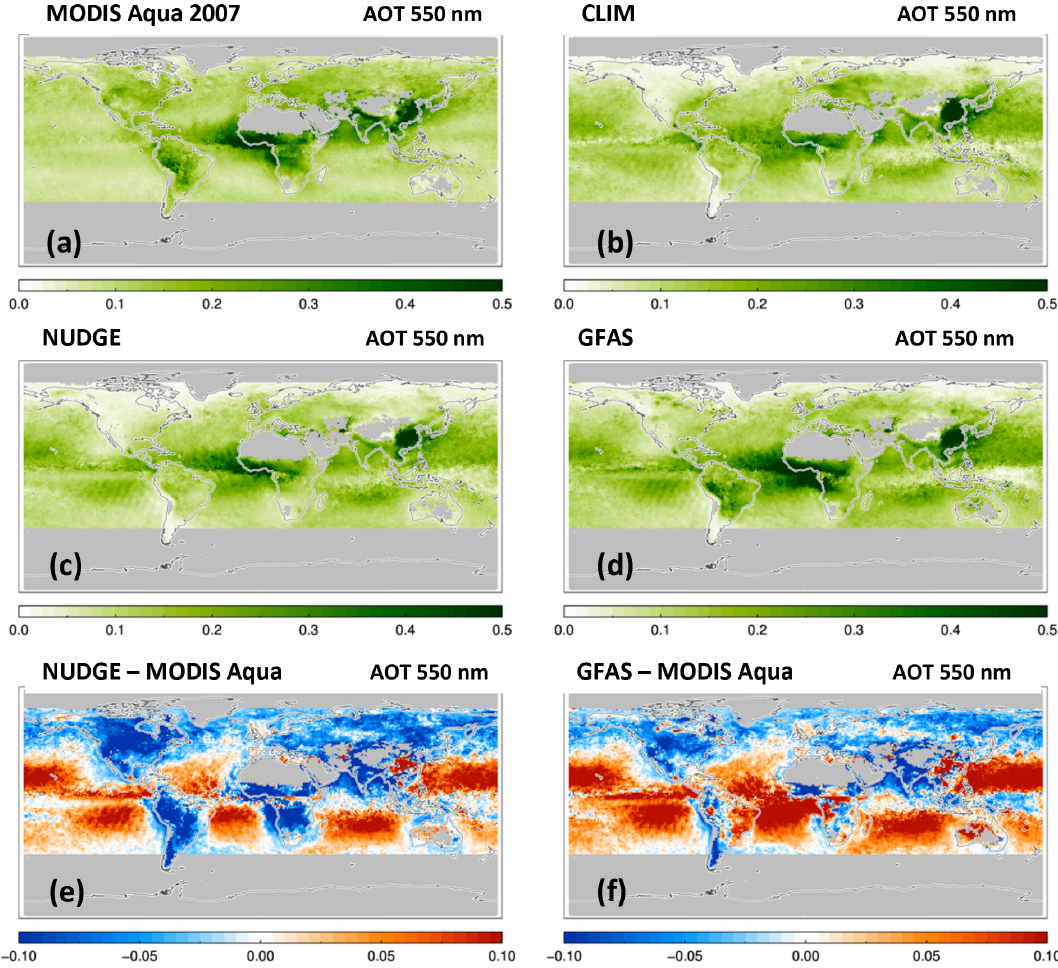
Figure 3. Comparison of annual average aerosol optical thickness (AOT) retrieved from MODIS Aqua satellite measurements (a) and for the experiments CLIM, NUDGE, and GFAS (b–d) for the year 2007. Additionally, differences between the simulated annual average of collocated AOT and the MODIS retrievals are given for the CLIM (e) and NUDGE (f) model